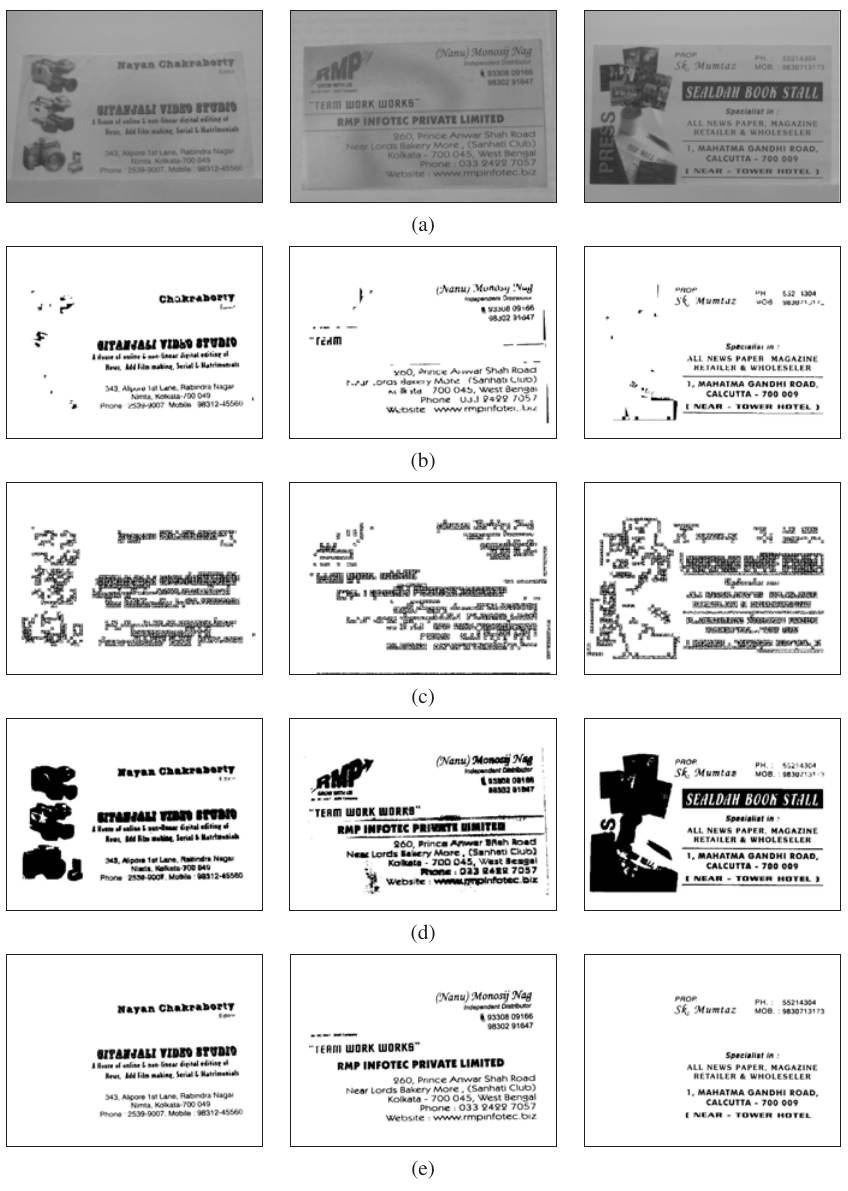
Figure 8. Binarized views of sample business card images with various methods. (a) Acquired business card images. (b) Xang’s character regions binarized with Otsu’s method. (c) Shin’s block adaptive binarization with modified quadratic filter. (d) Liu’s binarization method. (e) Proposed